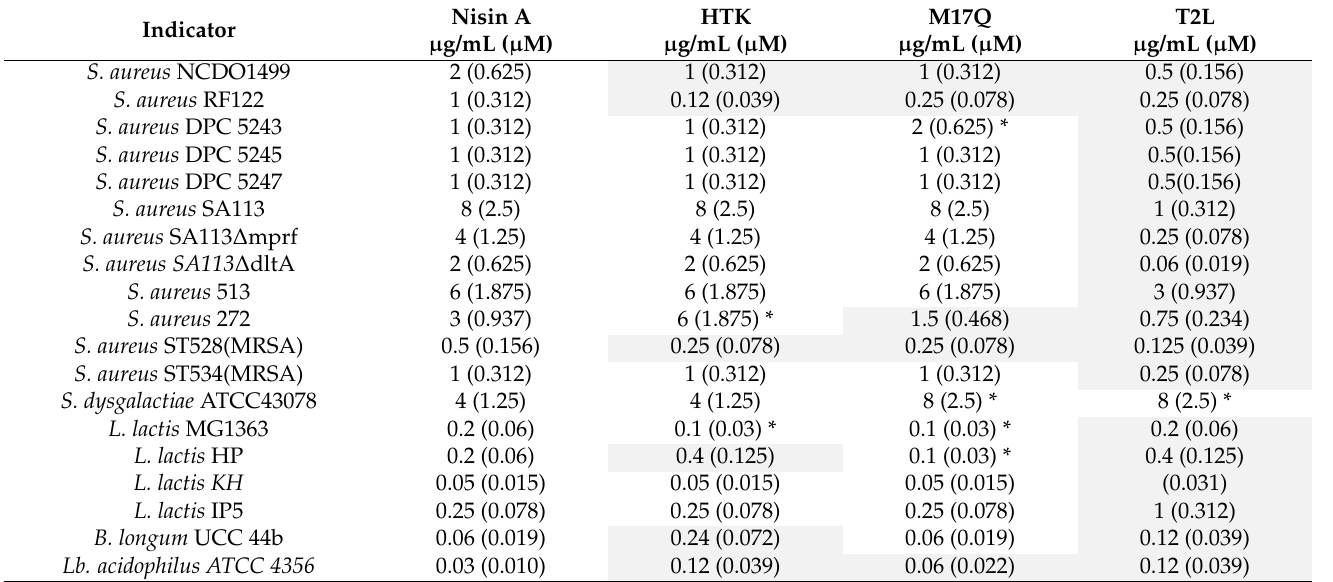
(Table 2) compared to nisin A (4 and 0.25 µ g/mL, respectively) and was also 16-fold more (Table 2). Table 2. Specific activity of nisin A, nisin A M17Q, nisin A T2L and nisin A HTK against a range of indicator organisms. Grey shading denotes a favourable outcome where specific activity is enhanced against staphylococci and reduced against a selec- tion of lactic acid bacteria/bifidobacteria. No shade denotes no change. No shade/asterisk denotes unfavourable outcome.